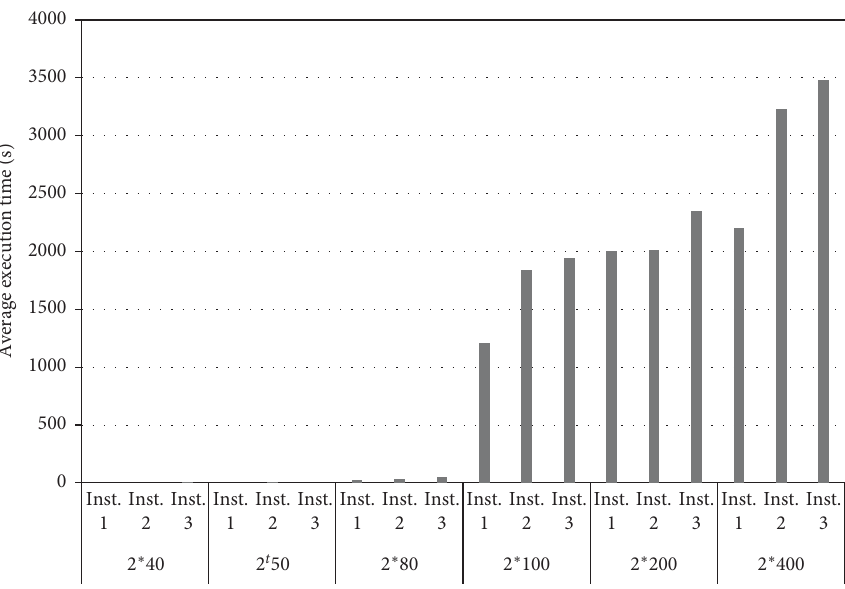
Figure 3: Comparison of average execution times for large